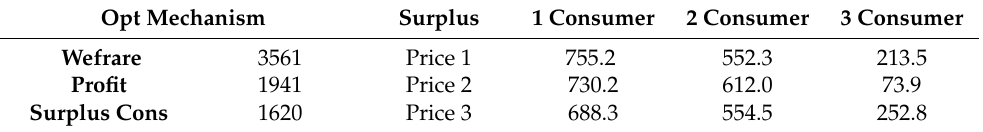
Table 3. Equilibrium characteristics for three consumers as calculated with the optimal